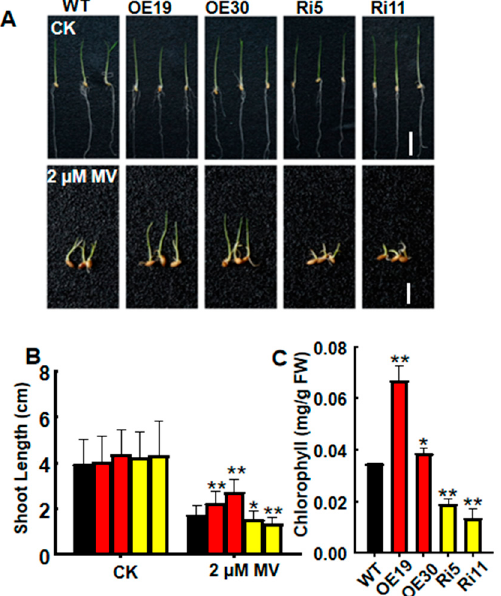
Figure 6 . Effects of MV on WT and OsASR6 transgenic rice. ( A ) Phenotypes of WT and transgenic seedling following treatment with 2 μ M MV. Scale bar: 2 cm in the upper images, 1 cm in the lower images. ( B ) Shoot length and ( C ) chlorophyll contents following 2 μ M MV and control (CK) treatment, respectively. Asterisks indicate significant differences between means of WT and transgenic lines. Three independent experiments were carried out with similar results. Data represent means ± SD ( n = 30). * p < 0.05, ** p < 0.01.